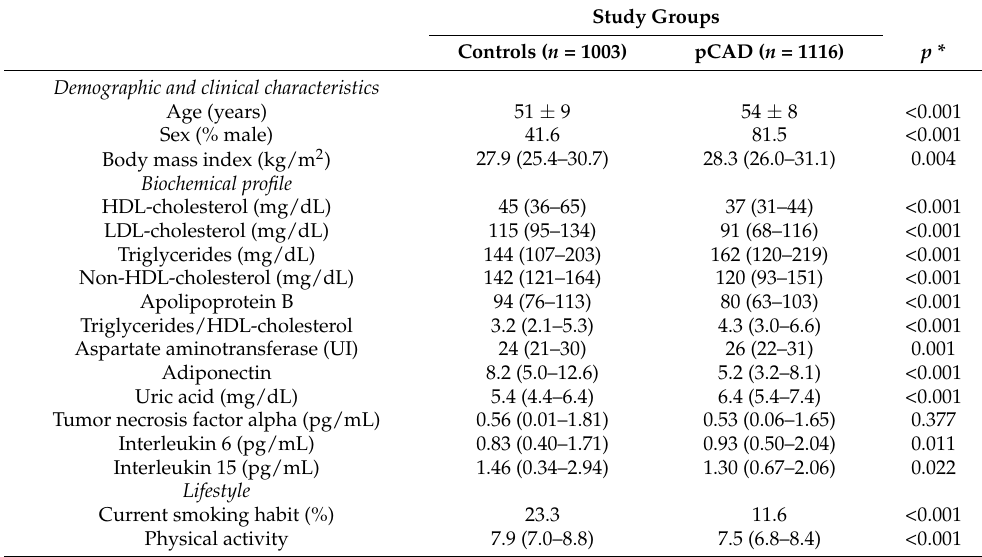
Table 1. Demographic, clinical, biochemical, and lifestyle characteristics in the study